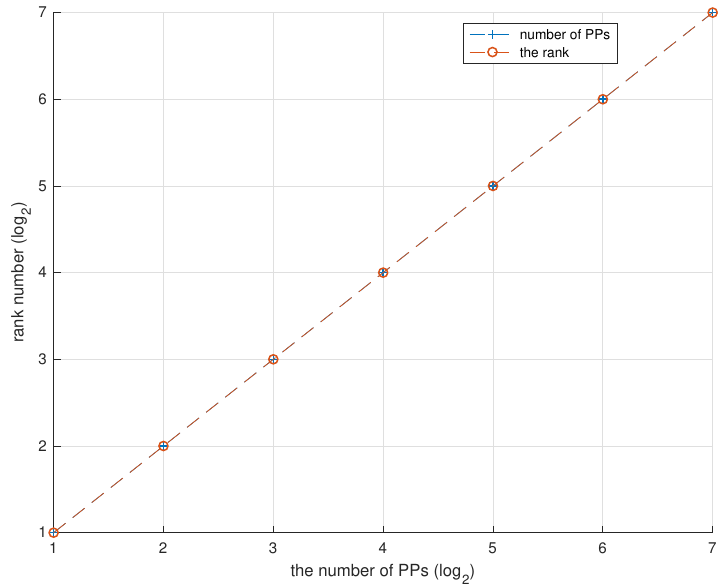
Figure 4. Without discontinuities, the rank of the coefficient matrix is always equal to the number of physical patches.